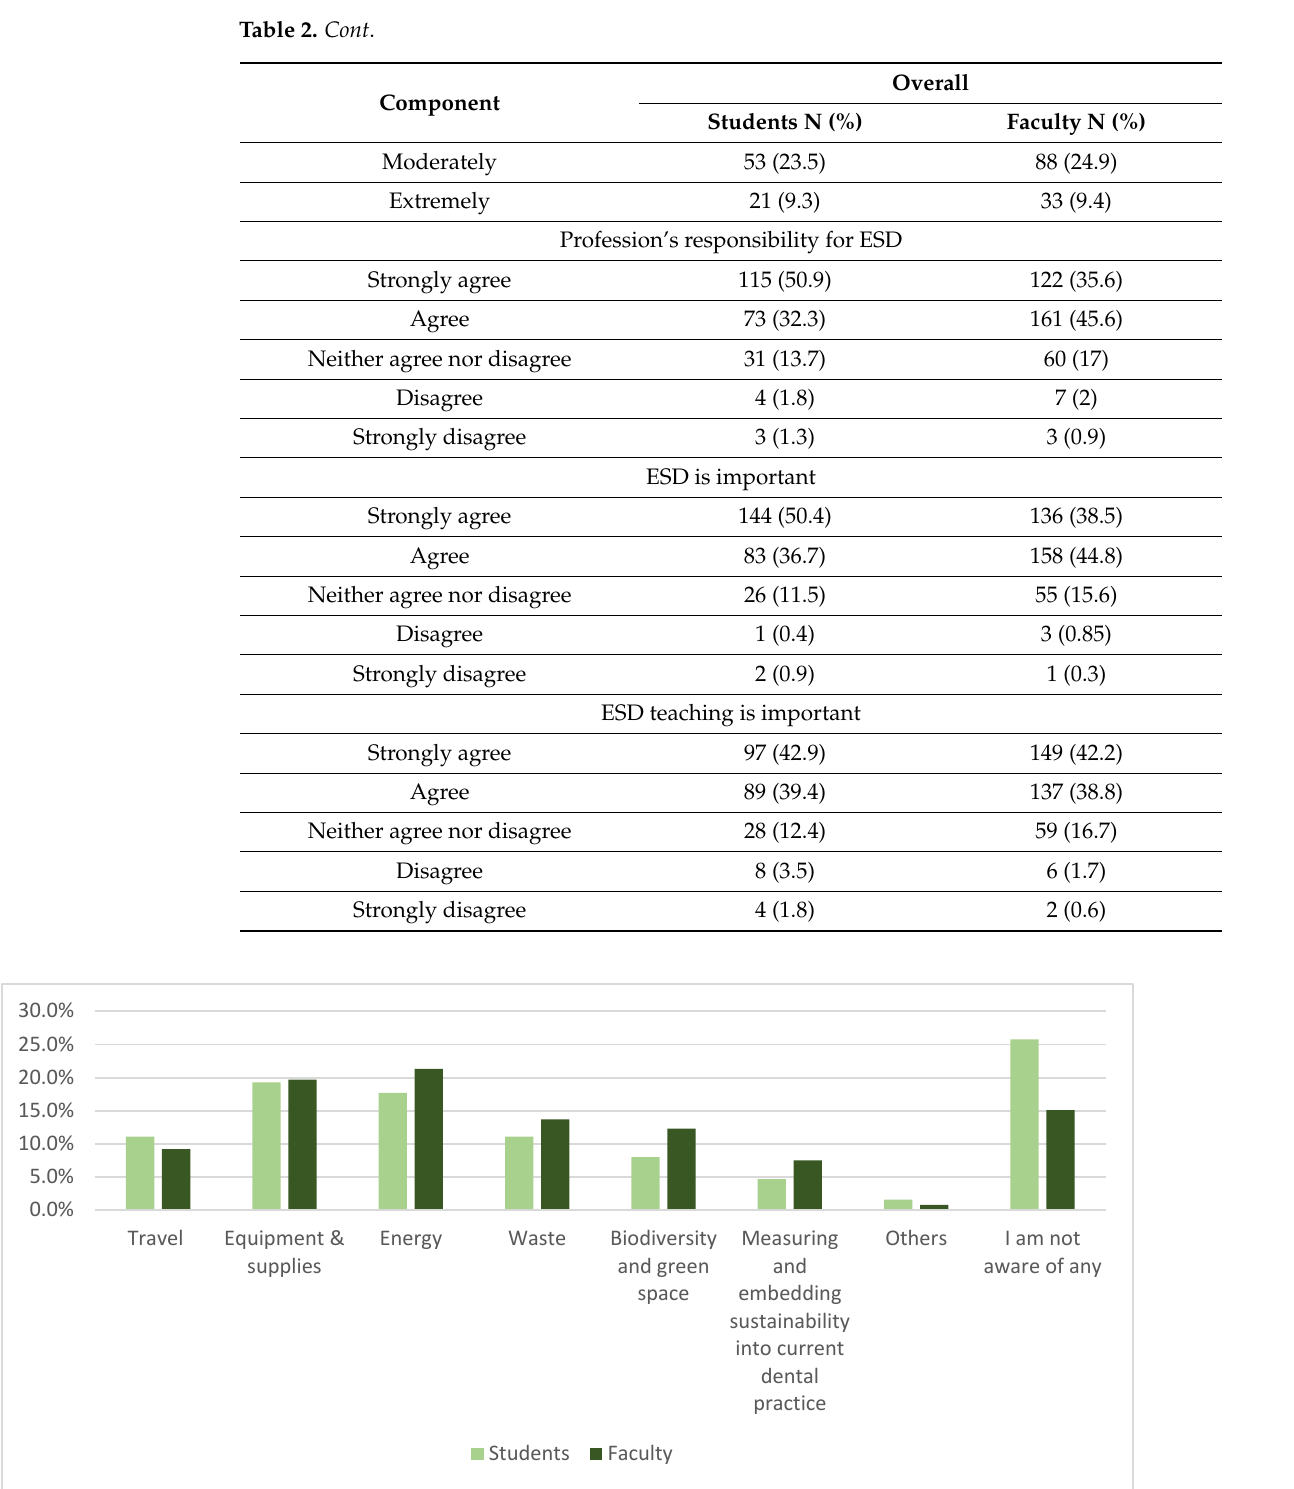
Table 3. Students’ and faculty’s interest in ESD teaching and learning.